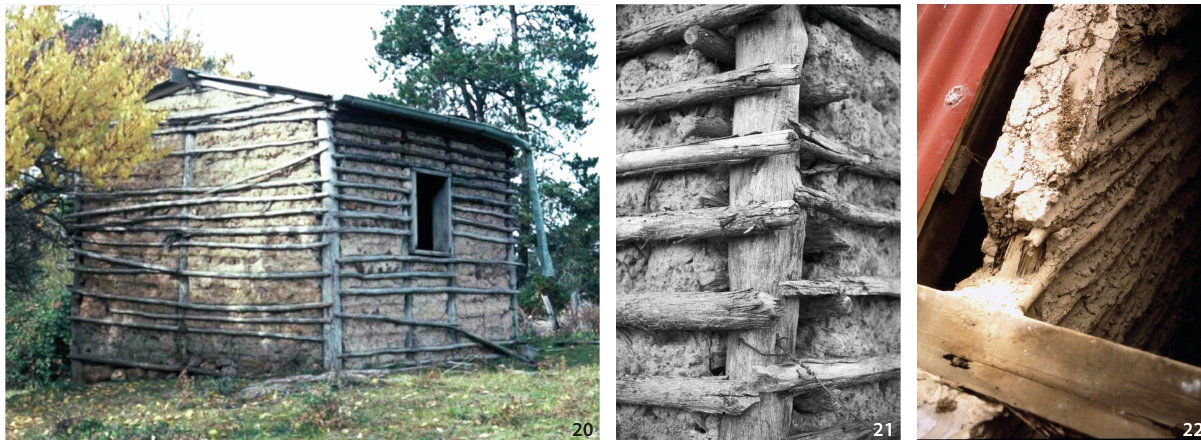
Figure 20 Hut at Wattle Flat, New South Wales (Source: Warwick Forge). Figure 21 Hut at Wattle Flat, New South Wales, corner detail (Source: Miles Lewis). Figure 22 Caldwell house, Merricks Road, Merricks, Victoria, 1860, detail at the edge of the gable (Source: Miles